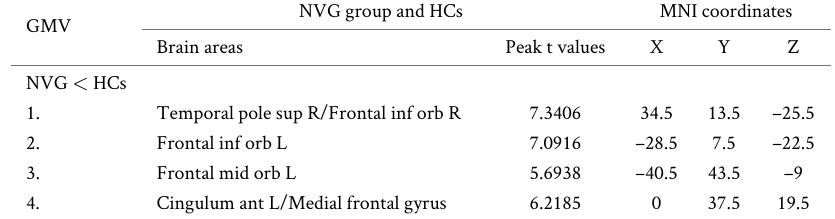
Table 3. GMV discrepancies between the NVG group and the HCs in several brain areas.